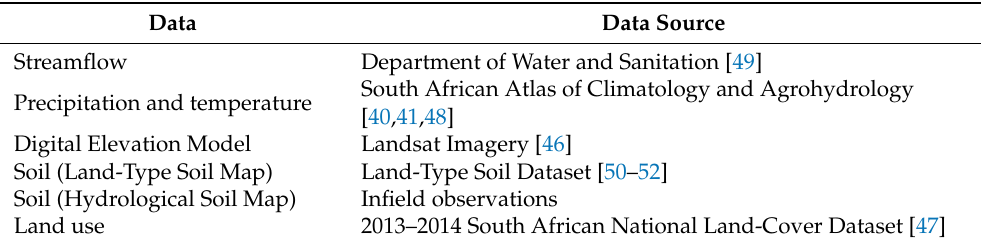
Table 6. Input data used in the SWAT+ model and their sources.